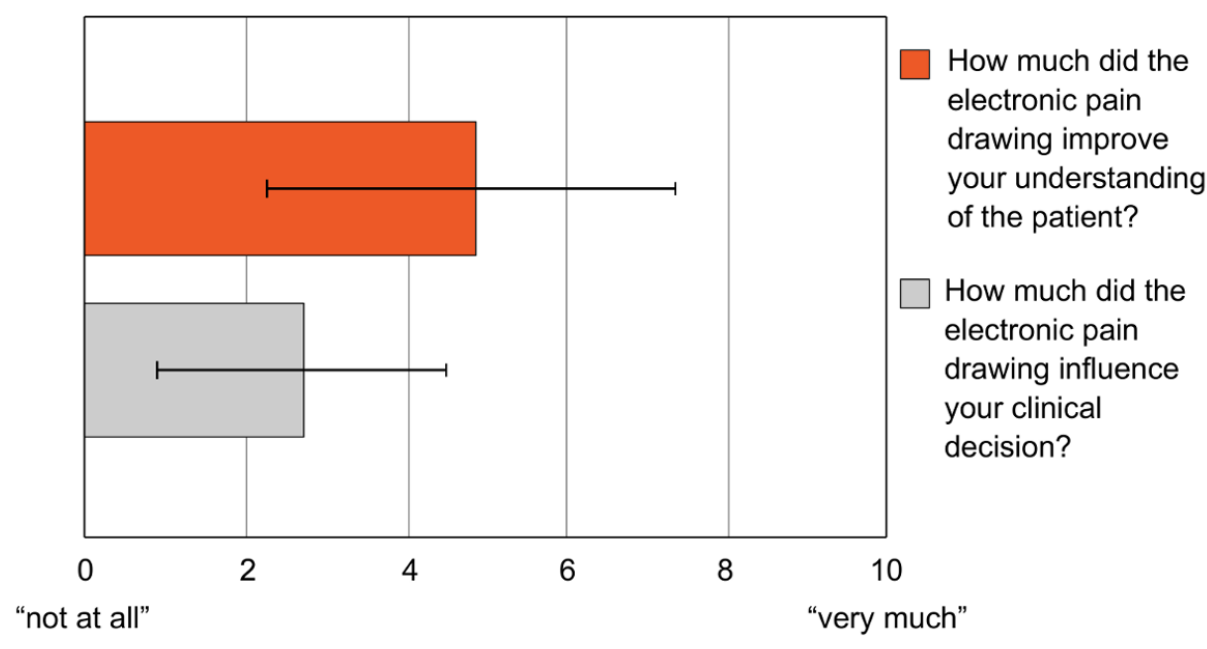
Figure 2. Impact of knowing patients’pain drawings (PDs) on understanding of the pain and clinical decision making as rated by the doctors. Patients’ PDs significantly improved the doctors’understanding of the pain and to a lesser but still significant extent influenced their clinical decision.